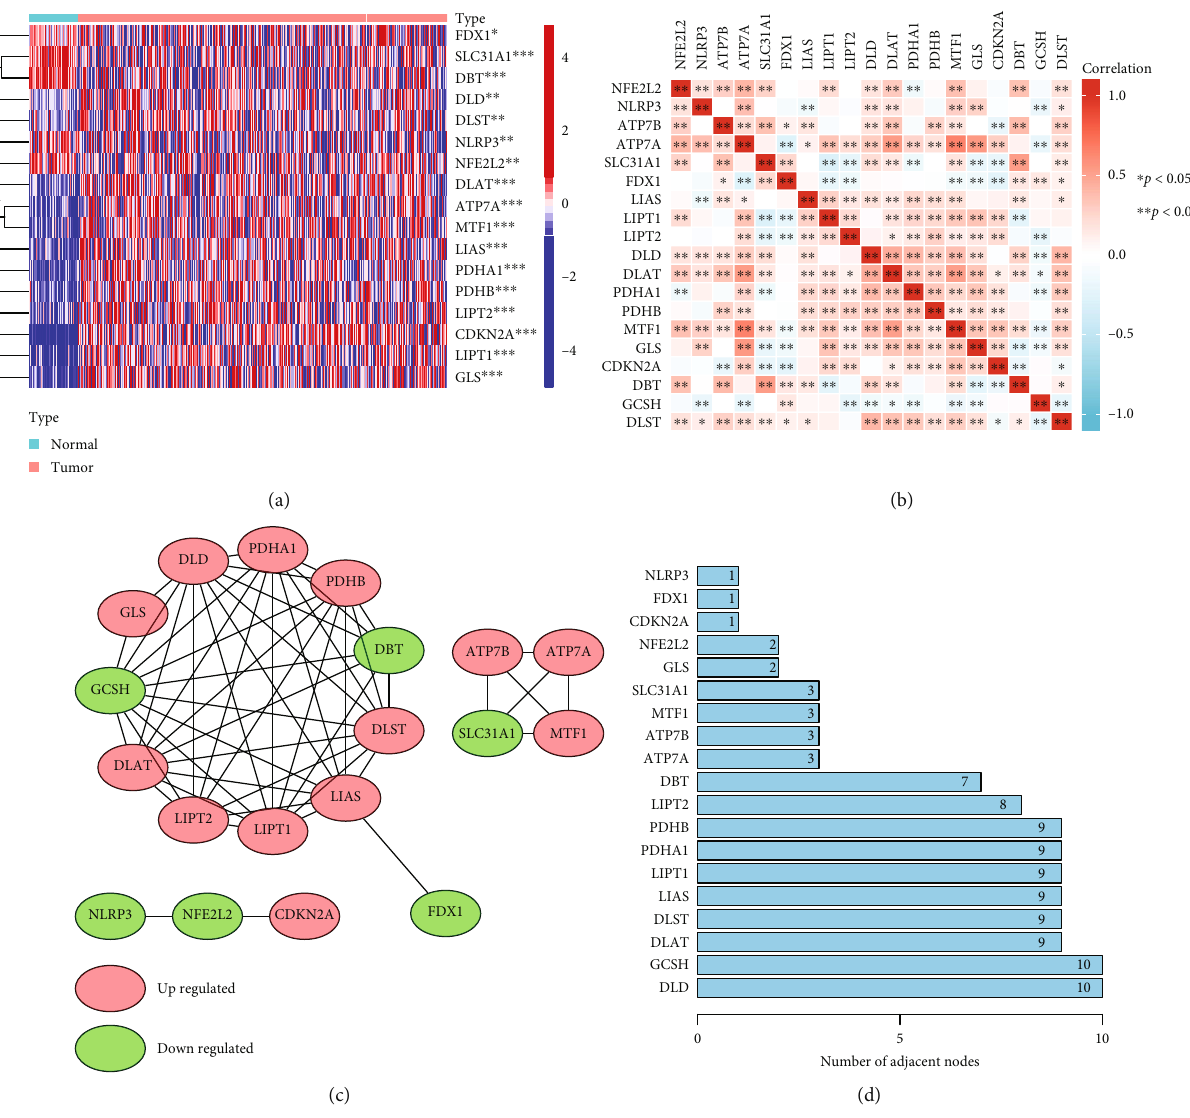
Figure 1: Identi fi cation of cuproptosis-related DEGs and exploration of the relationship between each CRG in HCC based on the TCGA database. (a) Cuproptosis-related DEGs expression patterns between HCC and normal tissue. The color legend represents the log2 (FPKM) value. (b) Pearson ’ s correlation analysis of each CRG based on the HCC samples. (c) PPI network plot displayed the relationship between each CRG. Red and green nodes indicate up and downregulated genes, respectively. (d) The number of adjacent nodes between each CRG in the PPI network. ∗ p < 0 : 05 , ∗∗ p < 0 : 01 , ∗∗∗ p < 0 : 001